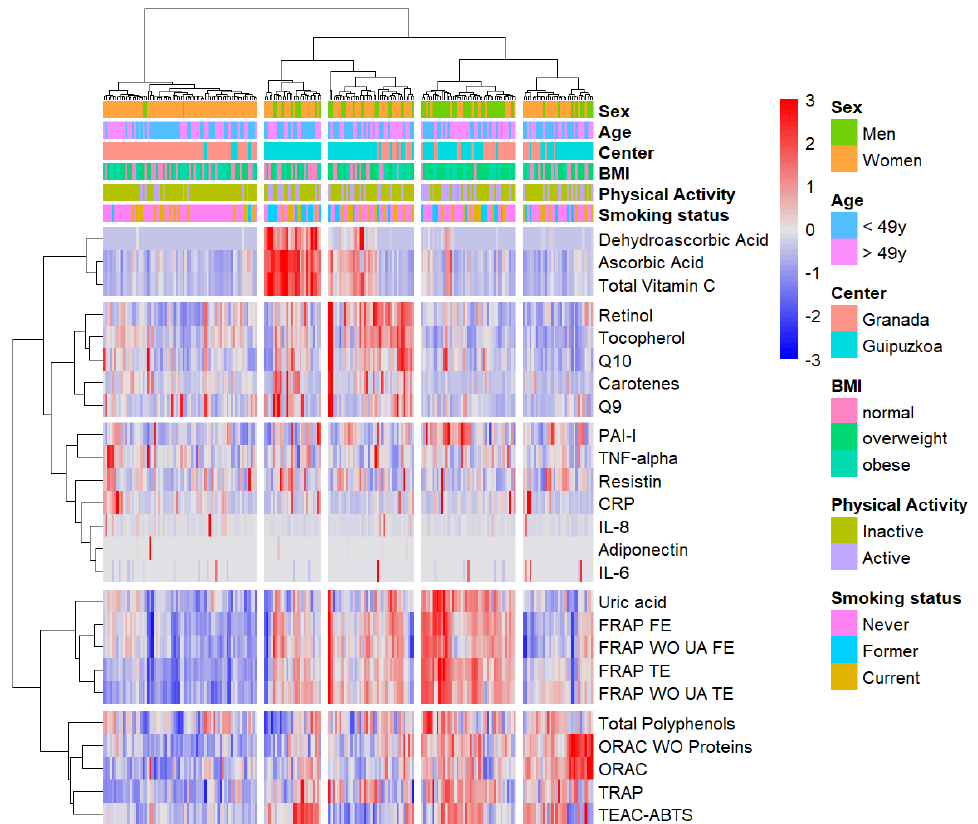
Figure 2. Hierarchical clustering analysis of the analyzed biomarkers across the samples. Unsupervised hierarchical clustering diagram for biomarker levels in 210 samples of the EPIC Granada-Gipuzkoa study. Subjects (samples) were clustered into hierarchical trees based on the levels of the biomarkers, which were clustered by their similarity (Manhattan distances). The clustering separated the biomarkers and subjects into distinct groups. The joined clusters minimized the maximum within-cluster distance. This value is the “height” at which the clusters merged, as indicated in the dendrogram, with height represented on the y-axis. The lower the y-axis value, the lower distance between the clusters and the stronger their relationship. Red indicates high biomarker levels and blue indicates low biomarker levels. Missing data in certain biomarkers appears in white.